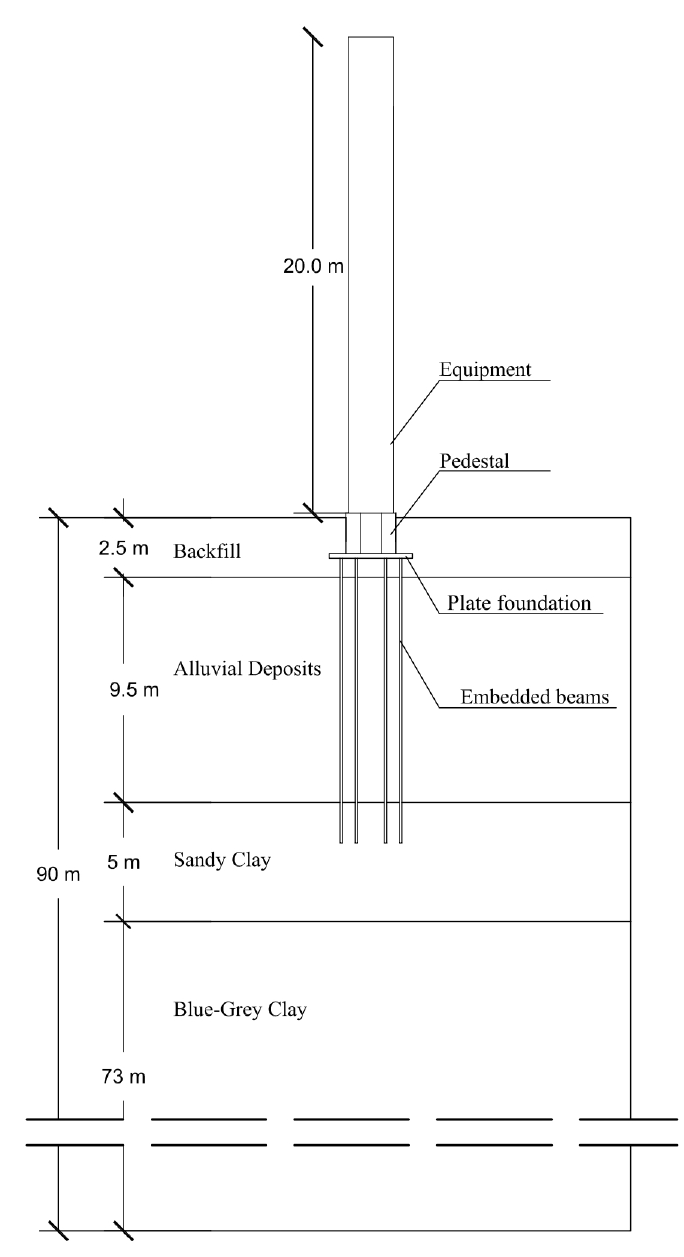
Figure 24. Schematic geometric model.